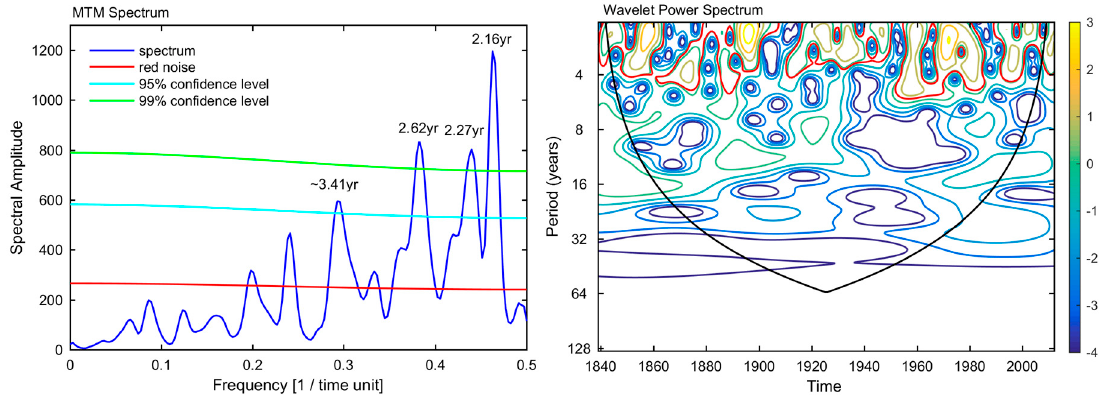
Figure 5. The multitaper method (MTM) spectrum analysis and Morlet wavelet analysis of the reconstructed inter-annual differences in September–October precipitation; the 5% significance level against red noise is displayed as a red contour